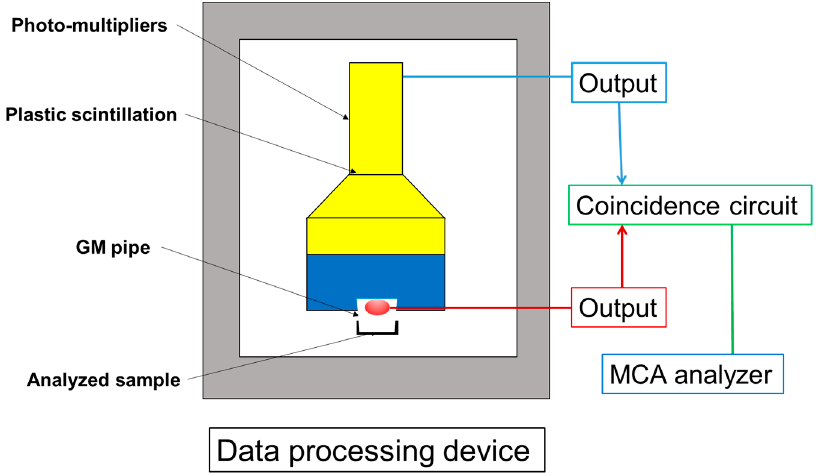
Figure 16. Pico-beta analyzer, TEPCO [82].